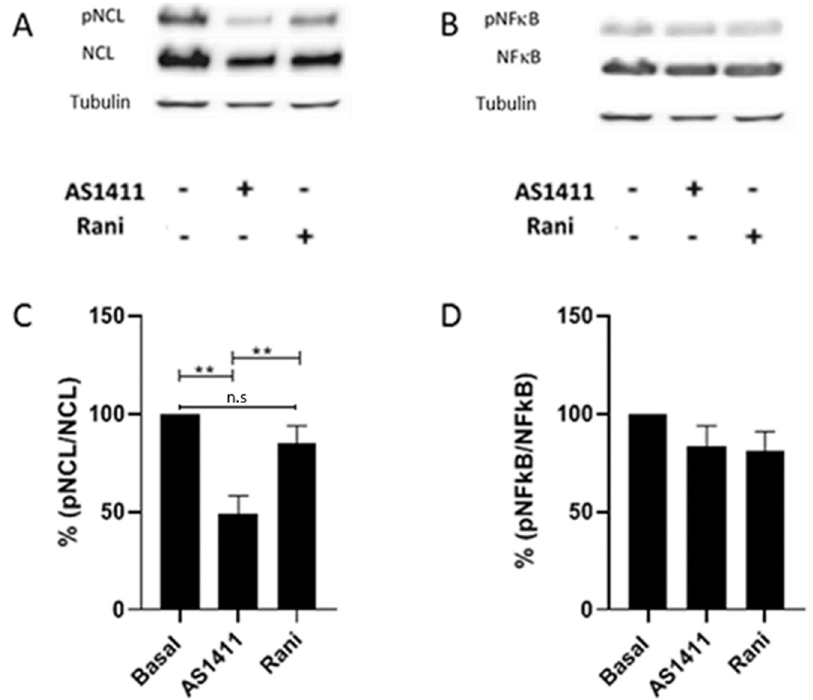
Figure 6. AS1411 decreases phospho-NCL in HUVEC. Cells were cultured in complete medium, AS1411 and ranibizumab were added for 24 h. After incubation period, the cells were lysed and proteins were blotted as indicated. AS1411 (10 µ M) was able to significantly inhibit NCL phosphorylation, compared to the control, while ranibizumab did not significantly affect NCL phosphorylation compared to the control ( A ). AS1411 and ranibizumab treatments did not affect NF κ B phosphorylation with respect to the control ( B ). Representative blots of three independent assays. Graphical representation of percentage of the pNCL/NCL ( C ), and pNF κ B/NF κ B ratio ( D ) among groups. Blots are representative of three independent assays. Bars represent mean (±SE). n = 3. ** p < 0.01.